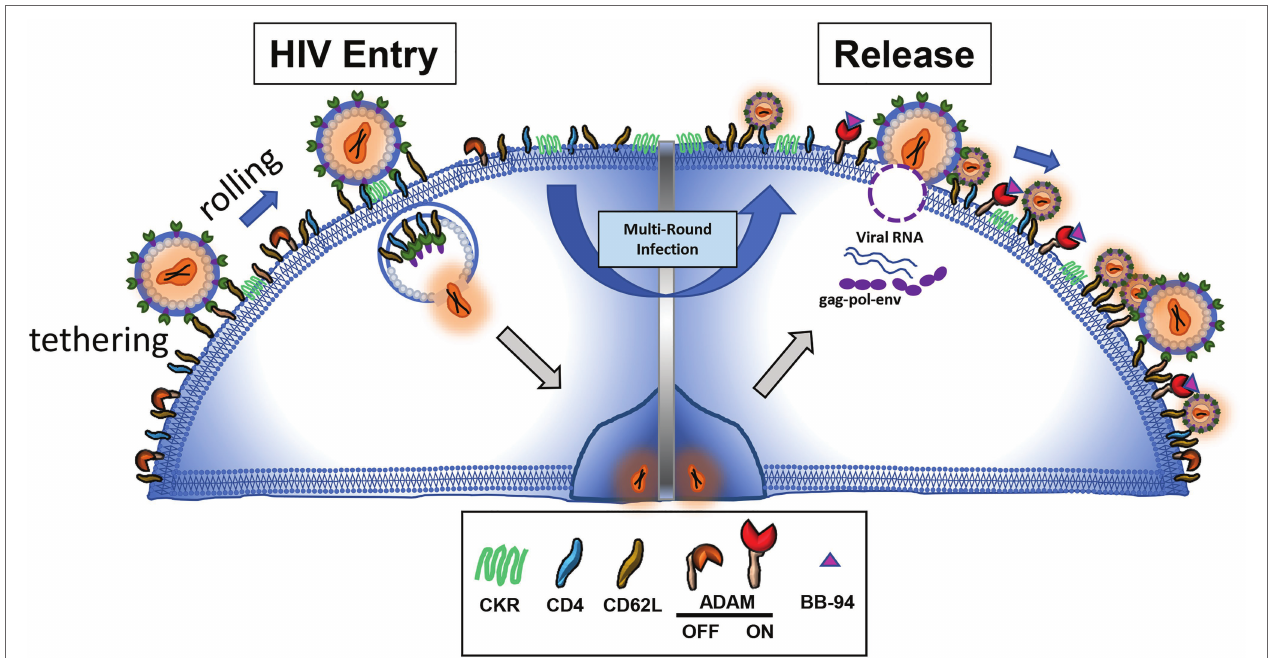
FIGURE 2 | L-selectin shedding is inhibited by metalloproteinase inhibitor BB-94, resulting in tethered and defective virions on infected